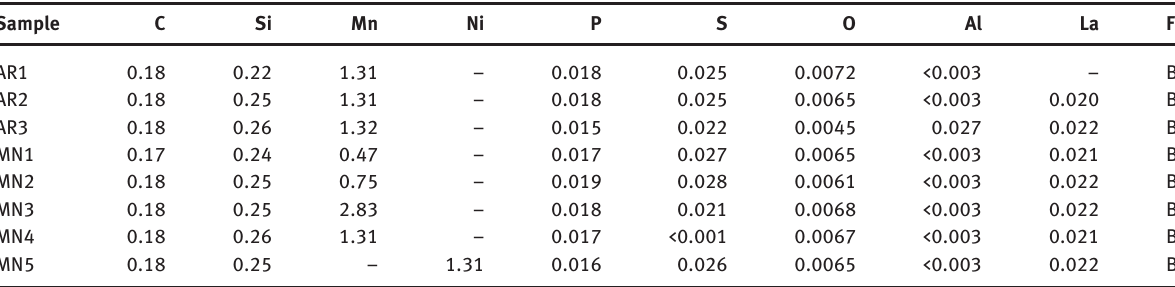
Table 1: The composition of each tested steel/mass%.